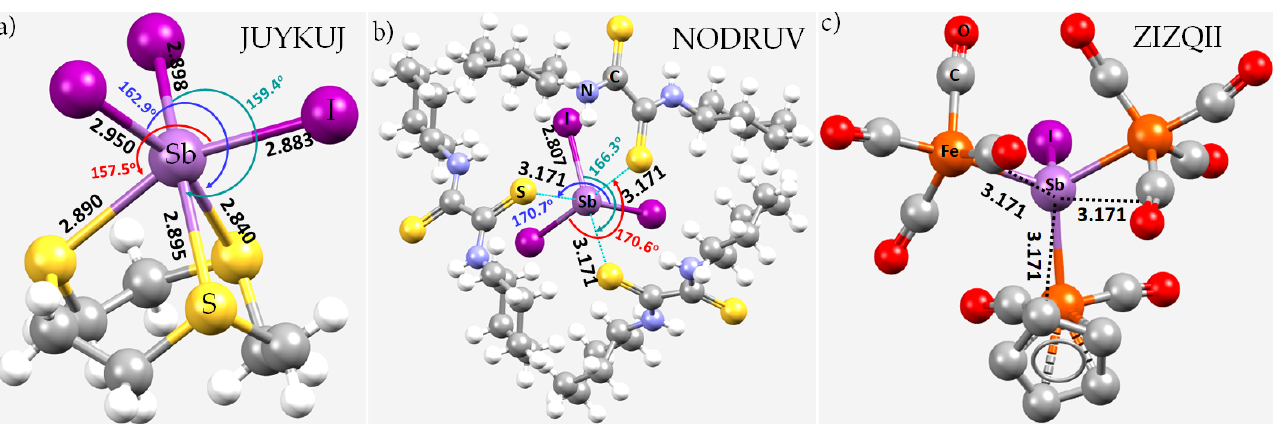
Figure 29. Examples of some host–guest complexes of ( a ) (HDTOA) 3 (SbI 3 ) 2 (HDTOA = N,N’ -dicyclohexyldithio-oxamide) [171]; ( b ) (9-S-3)SbI 3 (9-S-3 = 1,4,7-trithiacyclononane) [172]; ( c ) [( η 5 -cyclopentadienyl-Fe(CO) 2 )(Fe(CO) 4 ) 2 SbI] − [173]. For clarity, potential secondary interactions are omitted in most cases. Atom type is shown in some cases, and the CSD ref. code is given. Selected bond lengths and distances are shown in Å and degree, respectively.